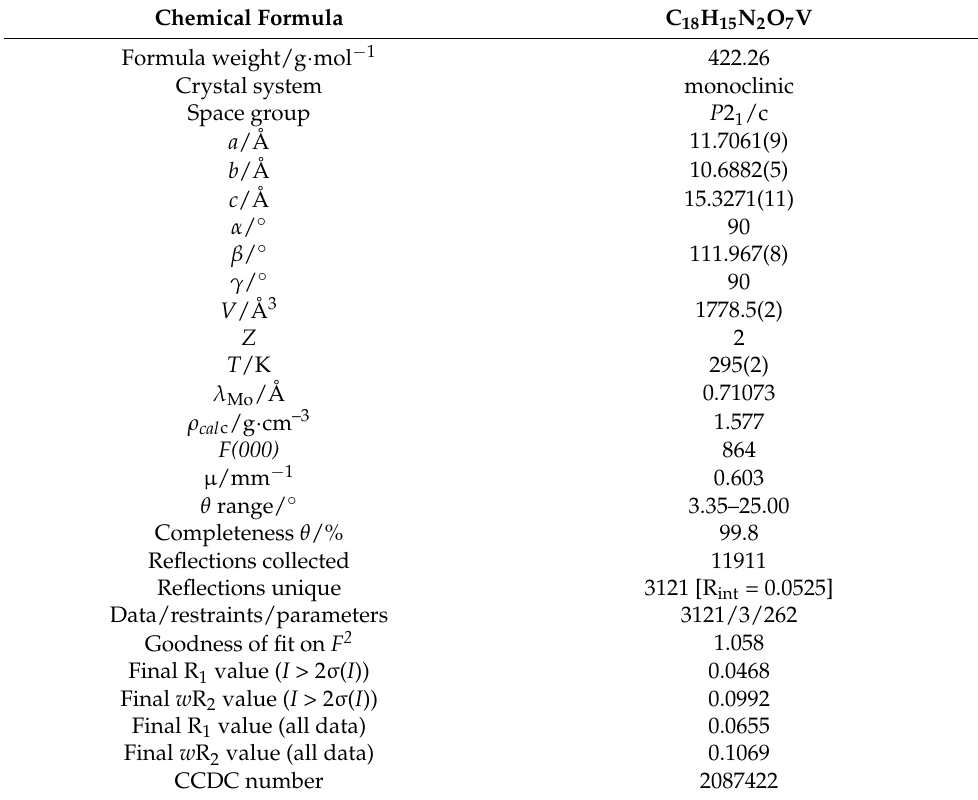
Figure 1. Molecular structure of [VOO(dipic)](2-phepyH) · H 2 O, showing the atom-labelling scheme (hydrogen bonds are represented by dashed lines). Table 1. Crystal data and structure refinement for [VOO(dipic)](2-phepyH) · H 2